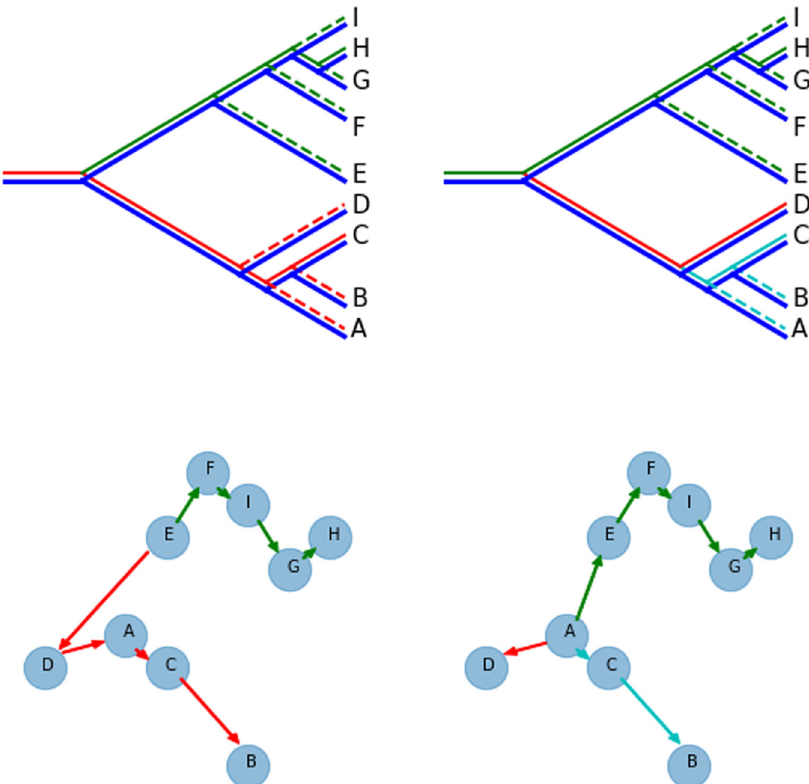
Fig. 4 Two hypothetical migratory histories through a given phylogenetic tree. The picture on the left takes location E as the point of origin, while that on the right takes point A as the origin. Arrow colors on the top and bottom elements of the fi gure show branching events and population